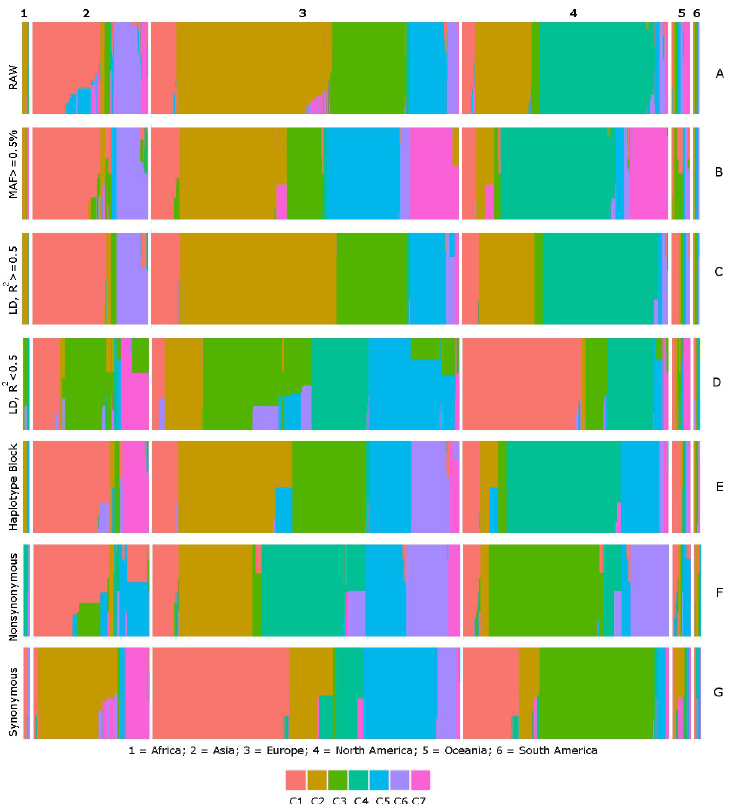
Fig 3. Identification of SARS-CoV-2 genetic clusters in different continents. Illustration of the seven (C1 to C7, color-coded) genetic subdivisions of SARS-CoV-2 sequences across continents using variants with MAF � 0.5%. Differential proportions of strong LD (C), weak LD (D), haplotype block (E), nonsynonymous (F), and synonymous (G) variants across continental datasets are shown.